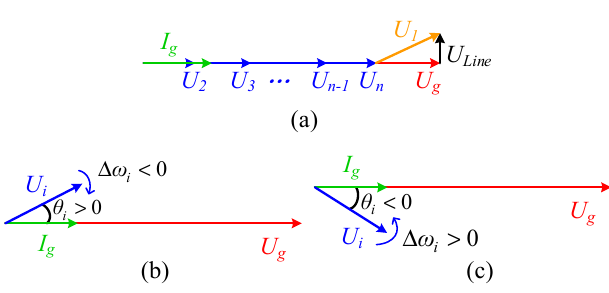
Figure 5. ( a ) Steady-state phasor diagram; ( b ) Self-synchronization process of inverter# i when θ i > 0; ( c ) Self-synchronization process of inverter# i when θ i < 0.